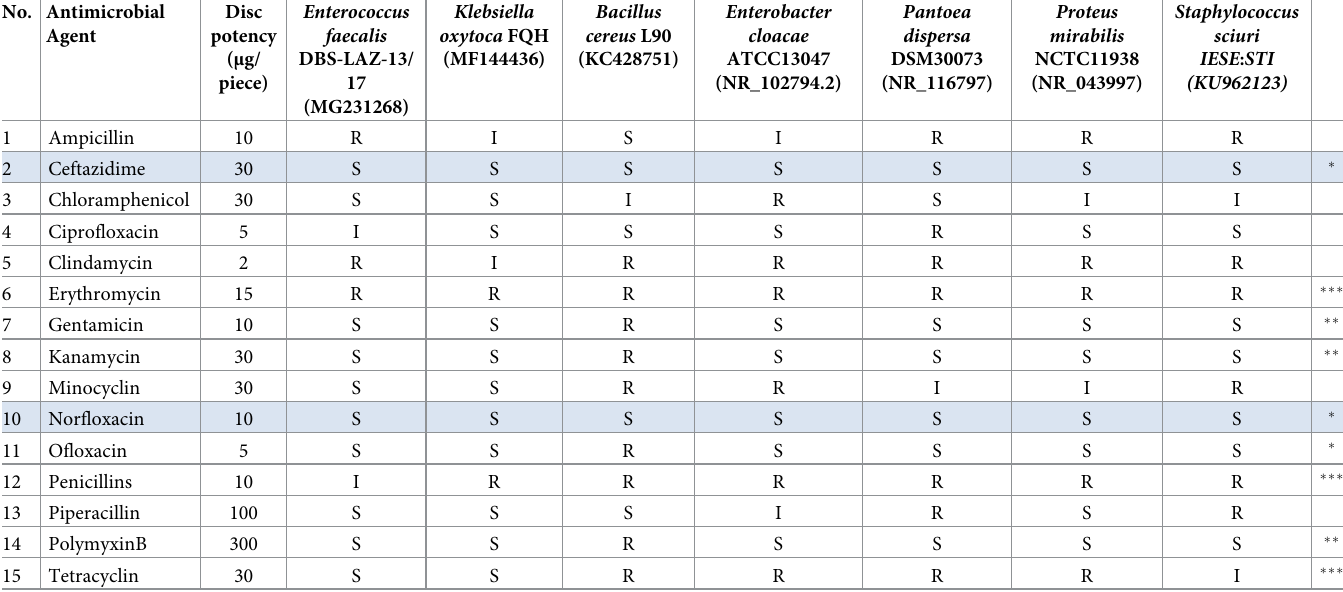
Our isolated bacteria sequences share 100% similarity with species from GenBank whose strains and accession numbers are provided. R = Resistant, S = susceptible, I = intermediate. R, S and I were determined after the in vitro susceptibility test. � = Antibiotics potent to all gut bacterial isolates